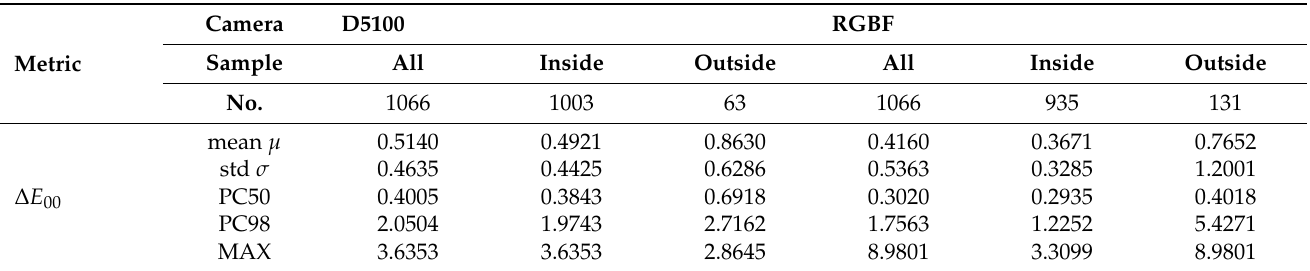
Table 7. Color difference ∆ E 00 statistics for the test samples using the third-order RPRM, where the cases with the D5100 and RGBF cameras are